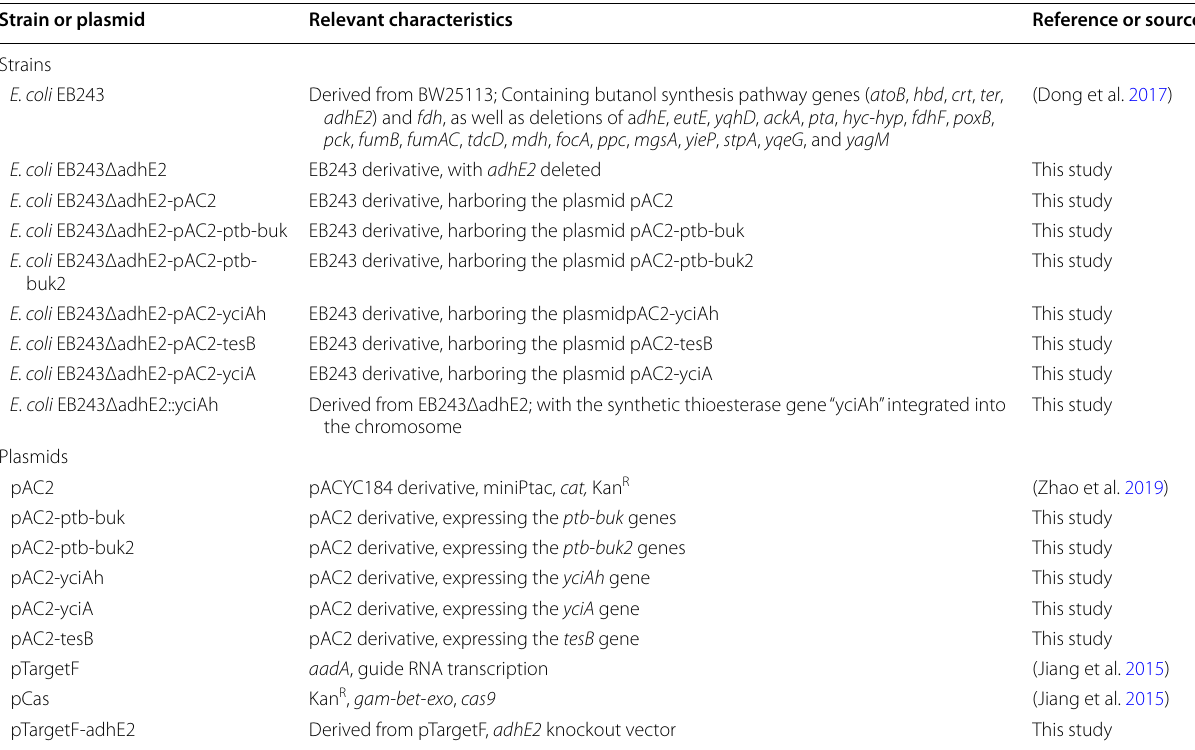
cat : chloramphenicol acetyl transferase gene; aadA : spectinomycin resistance gene; Kan R : kanamycin resistant strain; gam-bet-exo : Red recombinase genes; cas9 : Cas9 protein coding gene